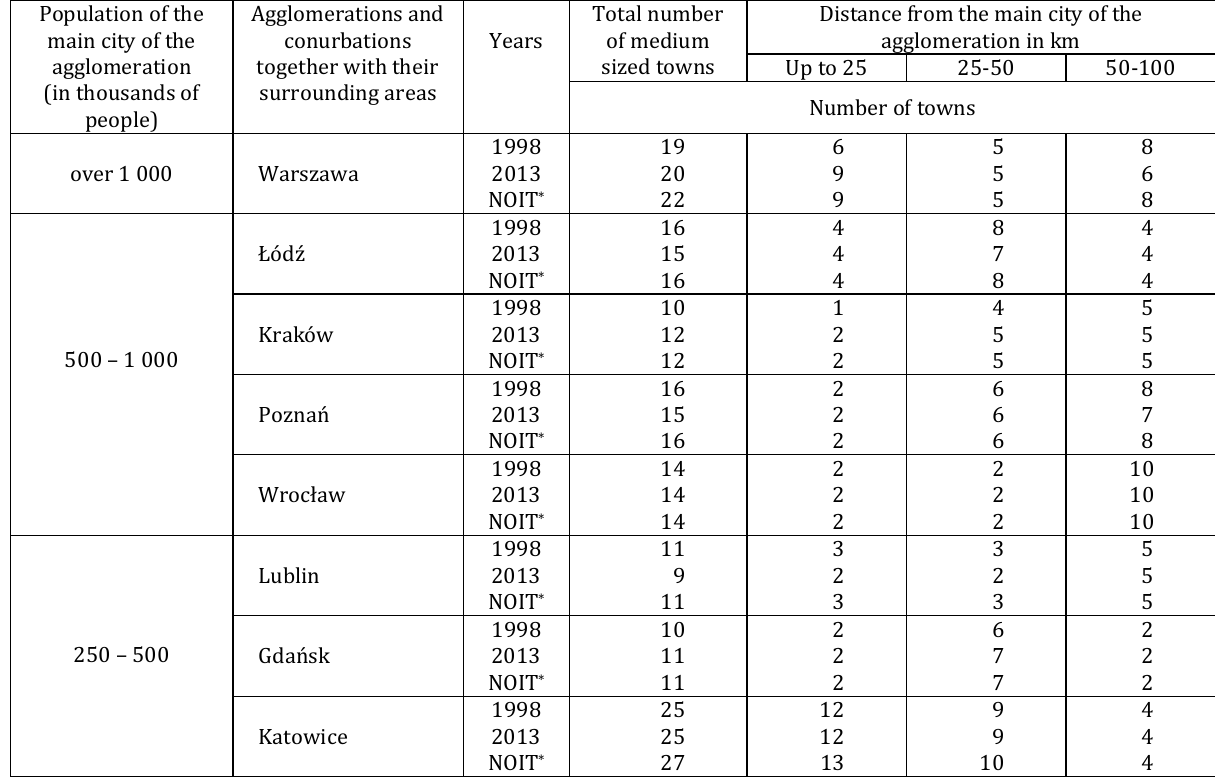
NOIT * – the number of investigated towns (the same number of towns comparable for both time periods). It includes towns which had from 20 to 100 thousand inhabitants in at least one of the investigated time